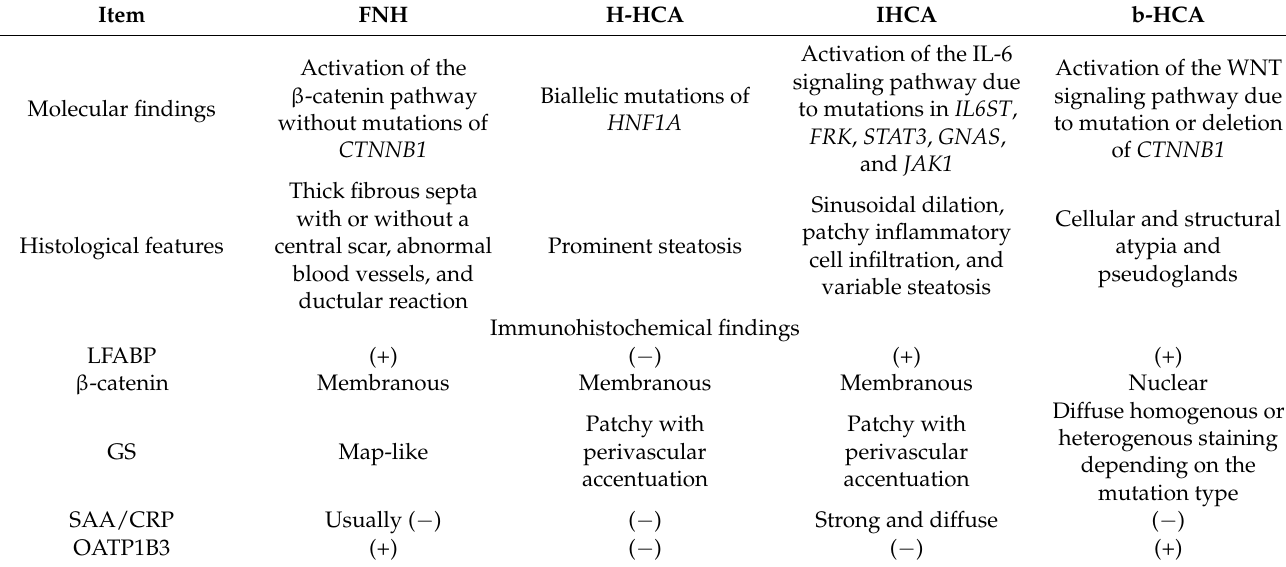
Table 2. Molecular findings, histological features, and immunohistochemical findings of FNH and